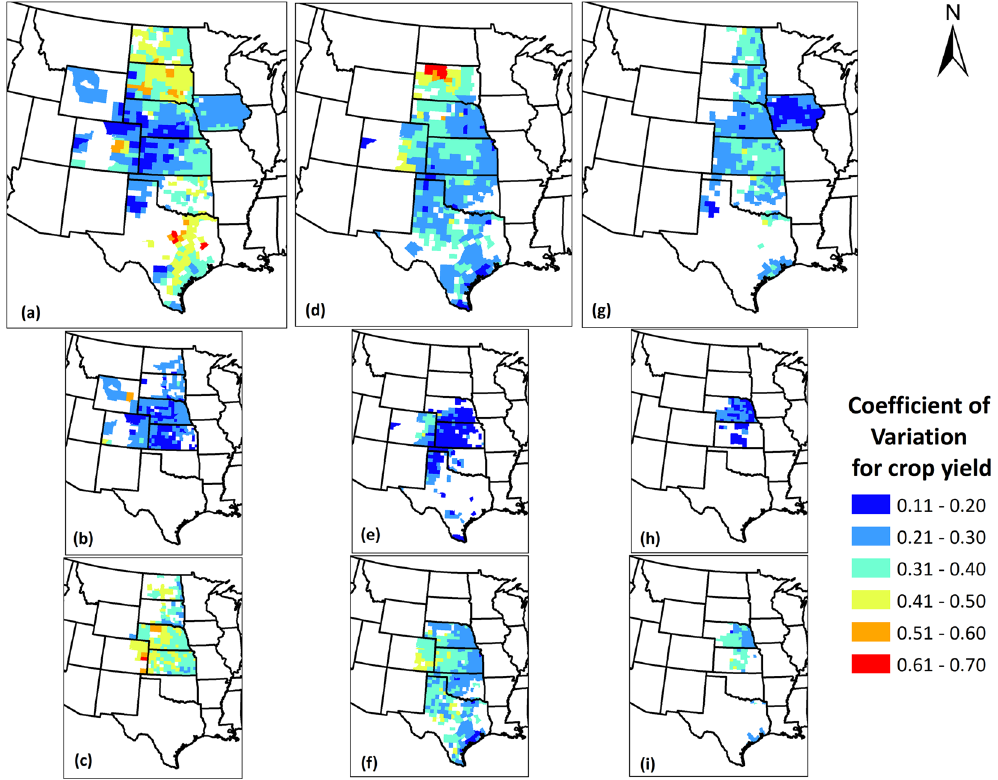
Figure 2. Coefficient of Variation for ( a ) Maize ( b ) Irrigated maize ( c ) Non-irrigated maize ( d ) Sorghum ( e ) Irrigated sorghum ( f ) Non-irrigated sorghum ( g ) Soybean ( h ) Irrigated soybean; ( i ) Non-irrigated soybean yields in the Great Plains counties over the period 1968–2013. Only those counties were shown which had at least 50% of the total data records. We created the maps using ESRI ArcMap 10.4.1 software http://desktop.